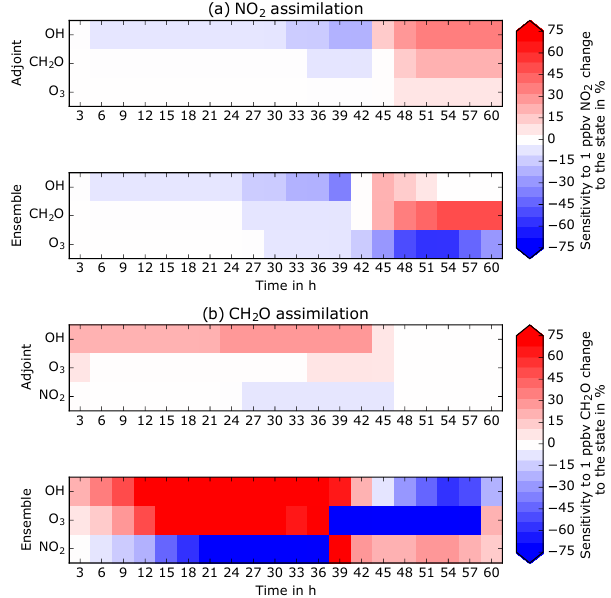
Figure 7. Temporal evolution of the sensitivities of the unobserved state species to changes from the observed one at the end of each 3h assimilation for NO 2 assimilation (a) and CH 2 O assimilation (b)